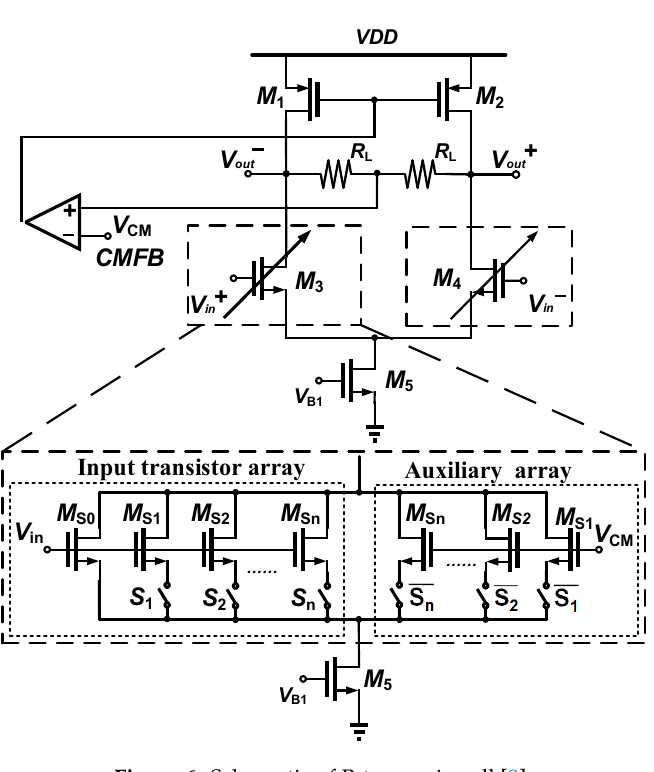
Figure 6. Schematic of B-type gain cell [9].